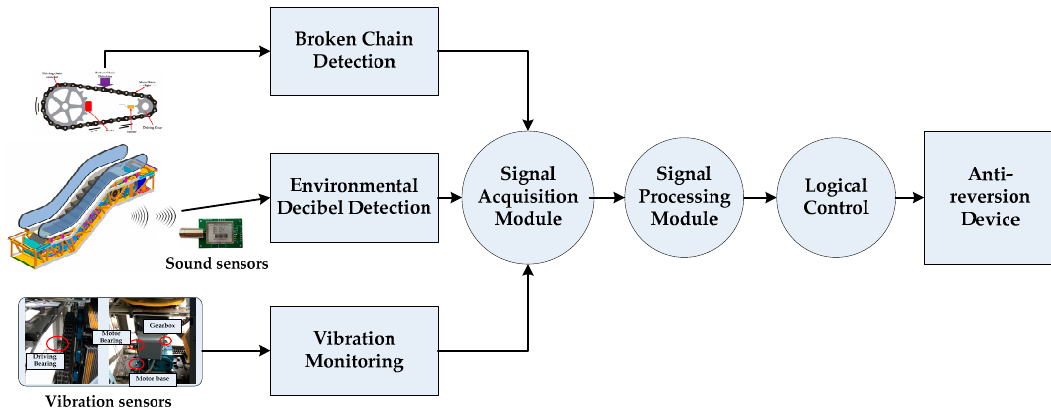
Figure 16. Comprehensive trigger mechanism of the anti-reversion device.